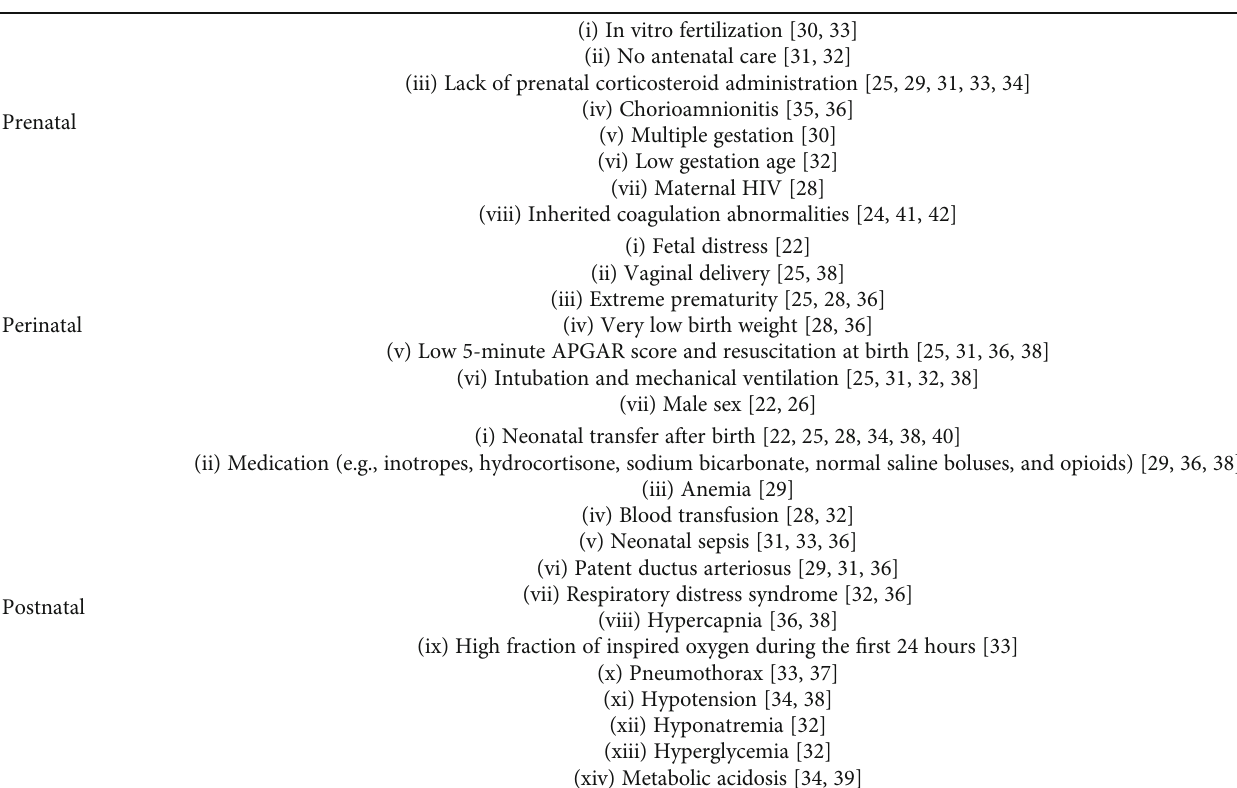
Figure 1: Grades of Table 1: Risk factors for GM-IVH in preterm infants.